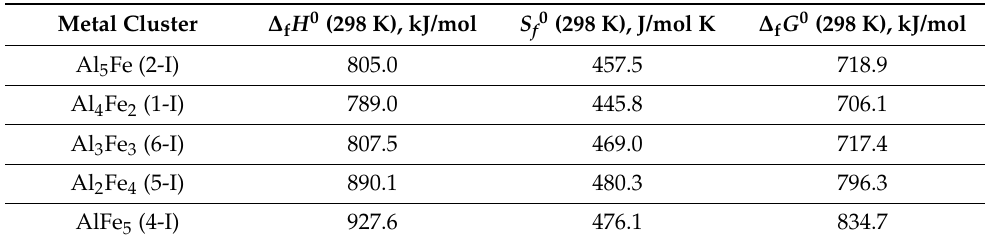
Table 10. Key structural parameters of the most stable AlFe 5 metal clusters. Table 11. Standard thermodynamic parameters of formation for the most energetically